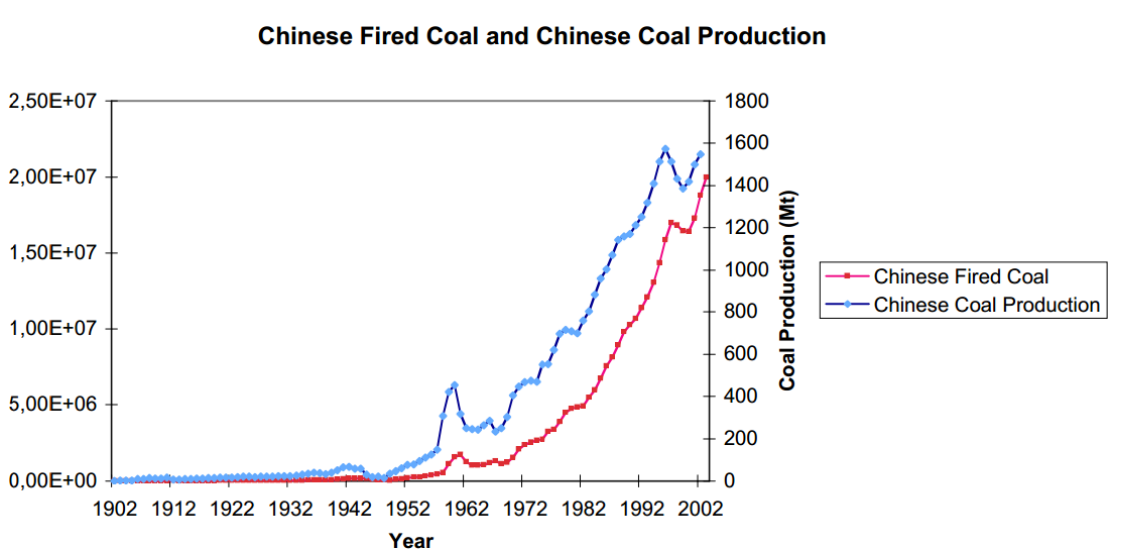
Figure 1. Chinese fired coal and Chinese coal production since